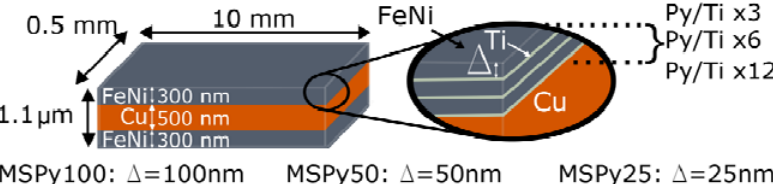
Figure 1. Schematic description of the Magneto-Impedance multilayer sandwiched (MS) structure used in this work. Each sample has different Py thickness ( Δ ) and different number of repetitions of the [Py/Ti] structure (3, 6 and 12 for samples MSPy100, MSPy50, and MSPy25, respectively), being the Cu central conductor of 500 nm in all cases.